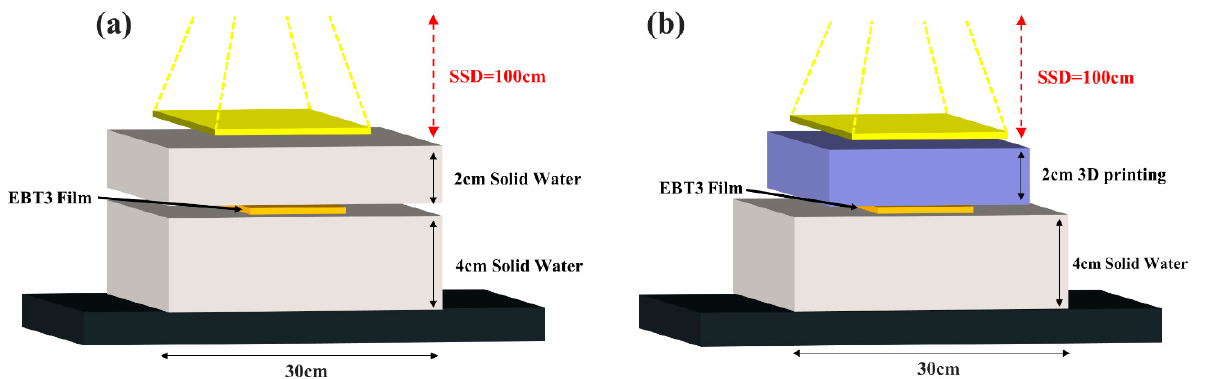
Figure 3. Irradiation of a clinical photon beam using a linear accelerator. ( a ) Photon beam irradiating the EBT3 film (PTW solid water layer with a thickness of 2 cm below). ( b ) Photon beam irradiating the EBT3 film (3D printed layer with a thickness of 2 cm below). Experiment consisting of inserting an EBT film between phantoms to evaluate the density uniformity of the phantom using a 6 MV photon beam. ( a ) Only commercially available solid water phantoms from PTW were used. ( b ) Solid water phantoms from PTW and 3D printed phantoms were used as substitutes in the experiment.